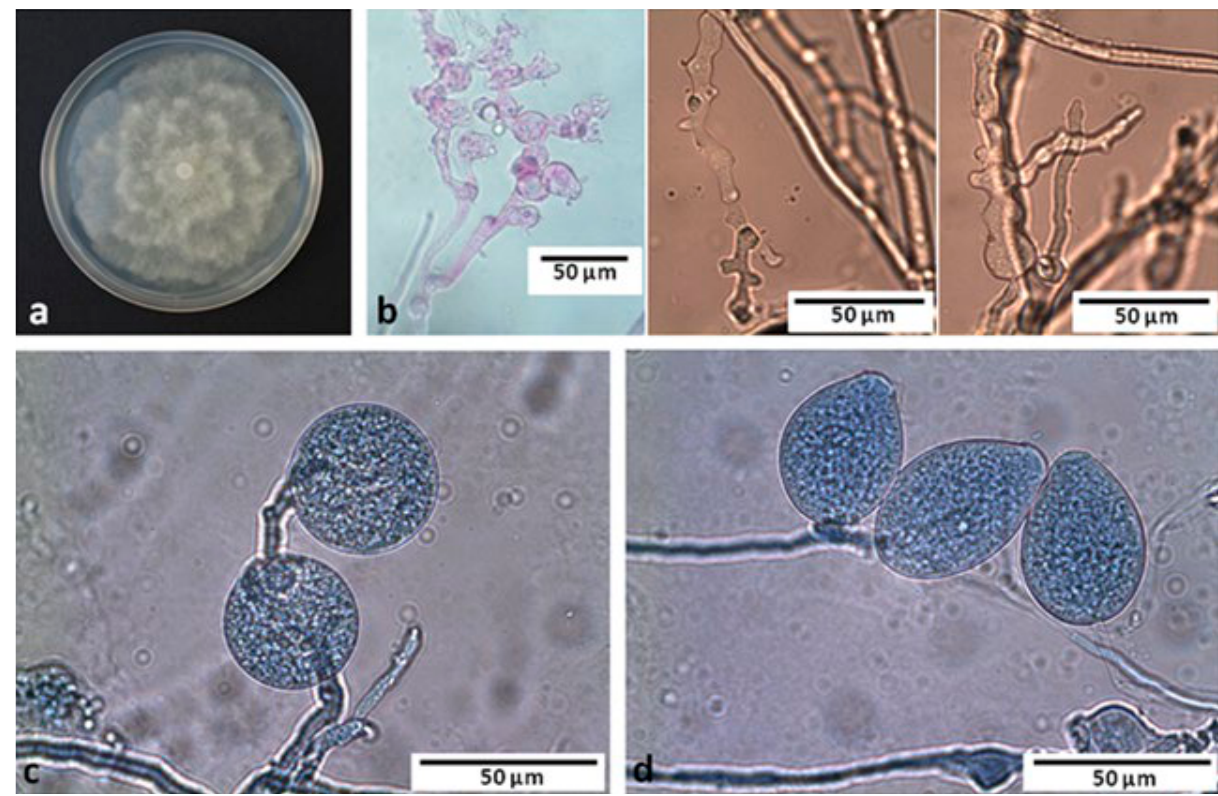
Figure 2. Morphological features of Phytophthora cinnamomi isolated from Platanus × acerifolia . Colony type (a); coralloid- type mycelium and hyphal swellings (b); chlamidospores (c); sporangia (d).